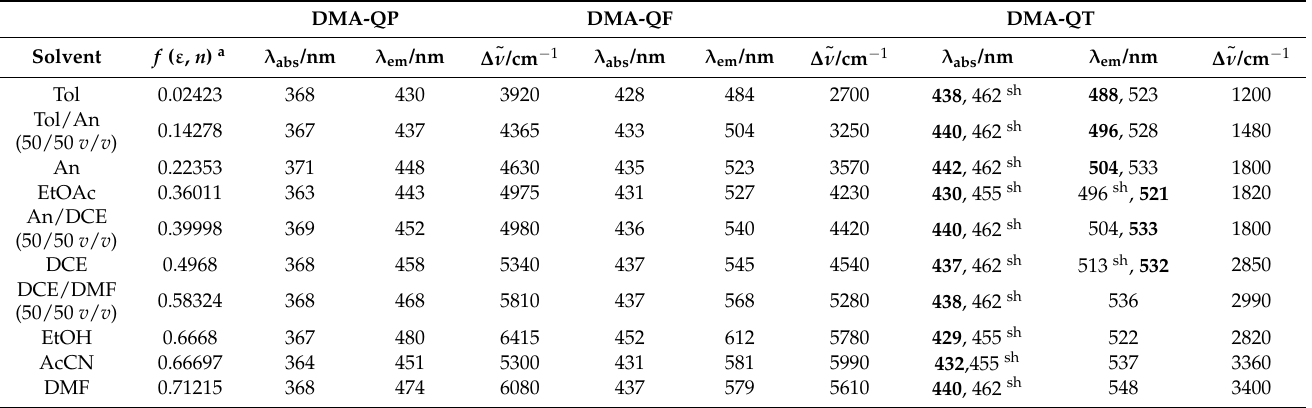
Table 1. Spectral properties of the investigated compounds in different solvents (dielectric constant, ε , and refractive index, n ) absorption maximum ( λ λ em ), Stokes shift ( ∆ (cid:101) ν ). abs ), emission maximum ( Bold values refer to the main absorption or emission maxima.